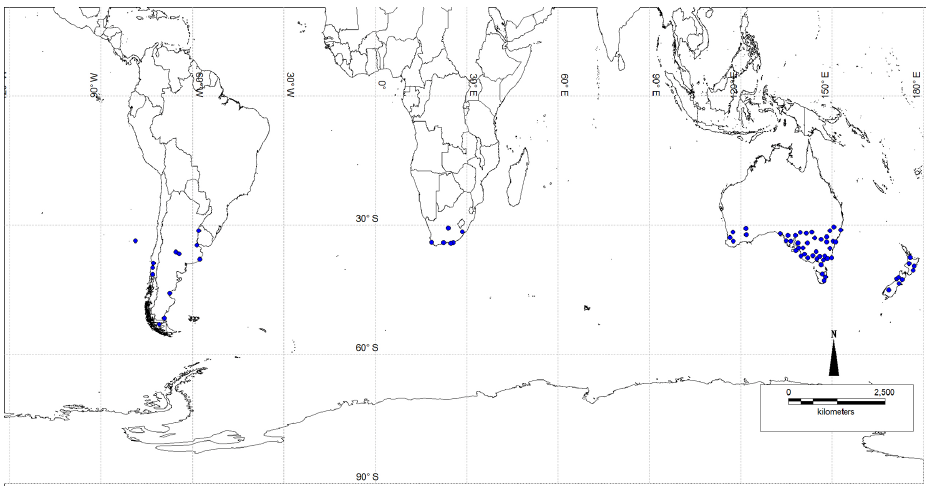
Figure 1. Location of 73 monthly rainfall stations used in this analysis (blue